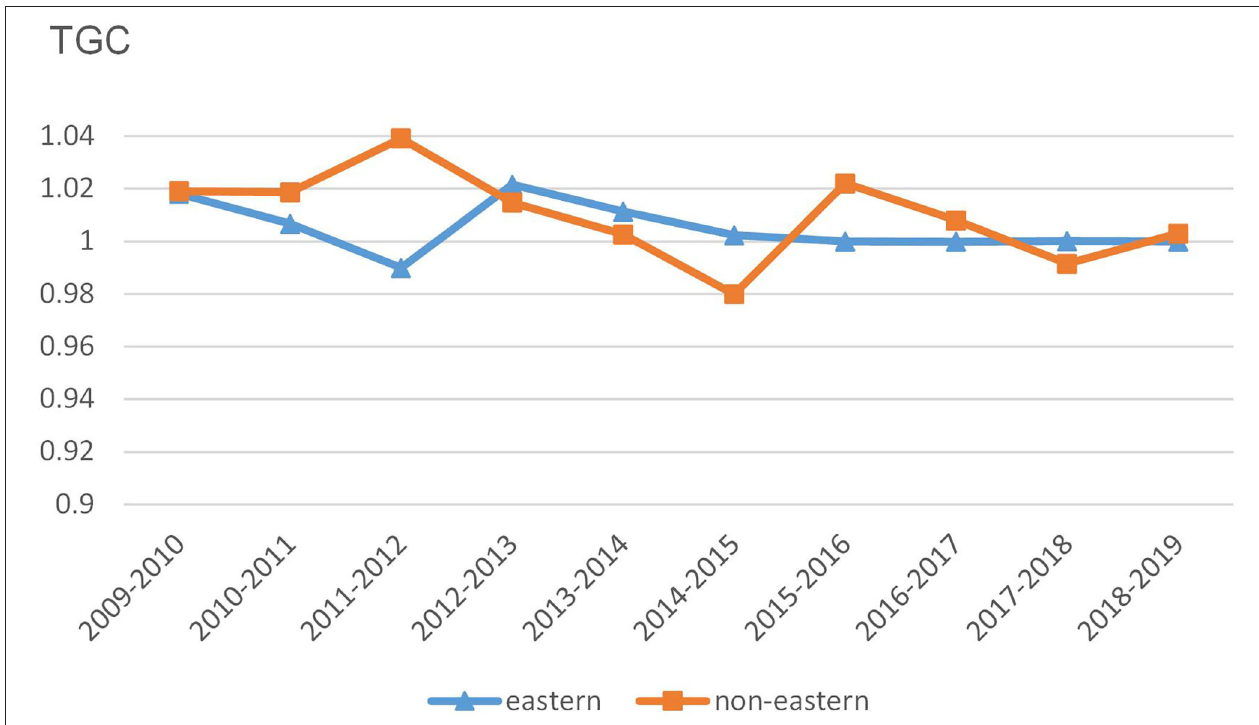
FIGURE 6 | Trends of TGC at the regional